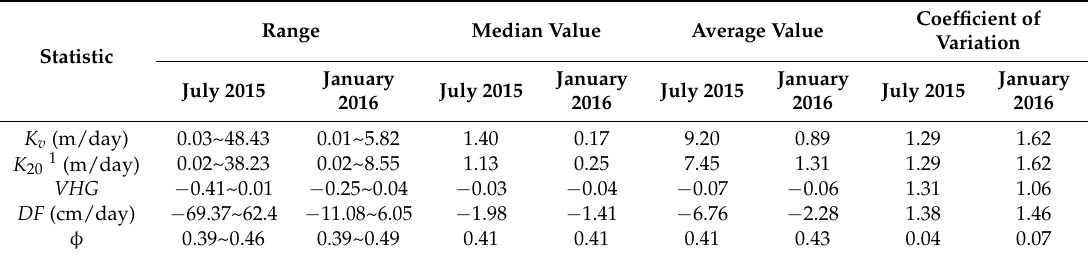
Table 2. Statistics of K v , K 20 , VHG , DF , and porosity ( φ ) during July 2015 and January 2016.